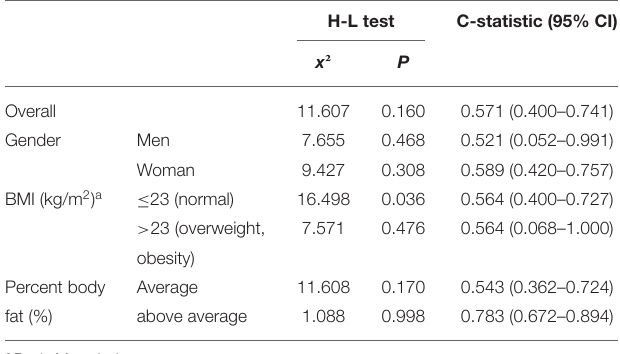
TABLE 2 | Hosmer-Lemeshow goodness of fit test and ROC curve for eGL prediction model.